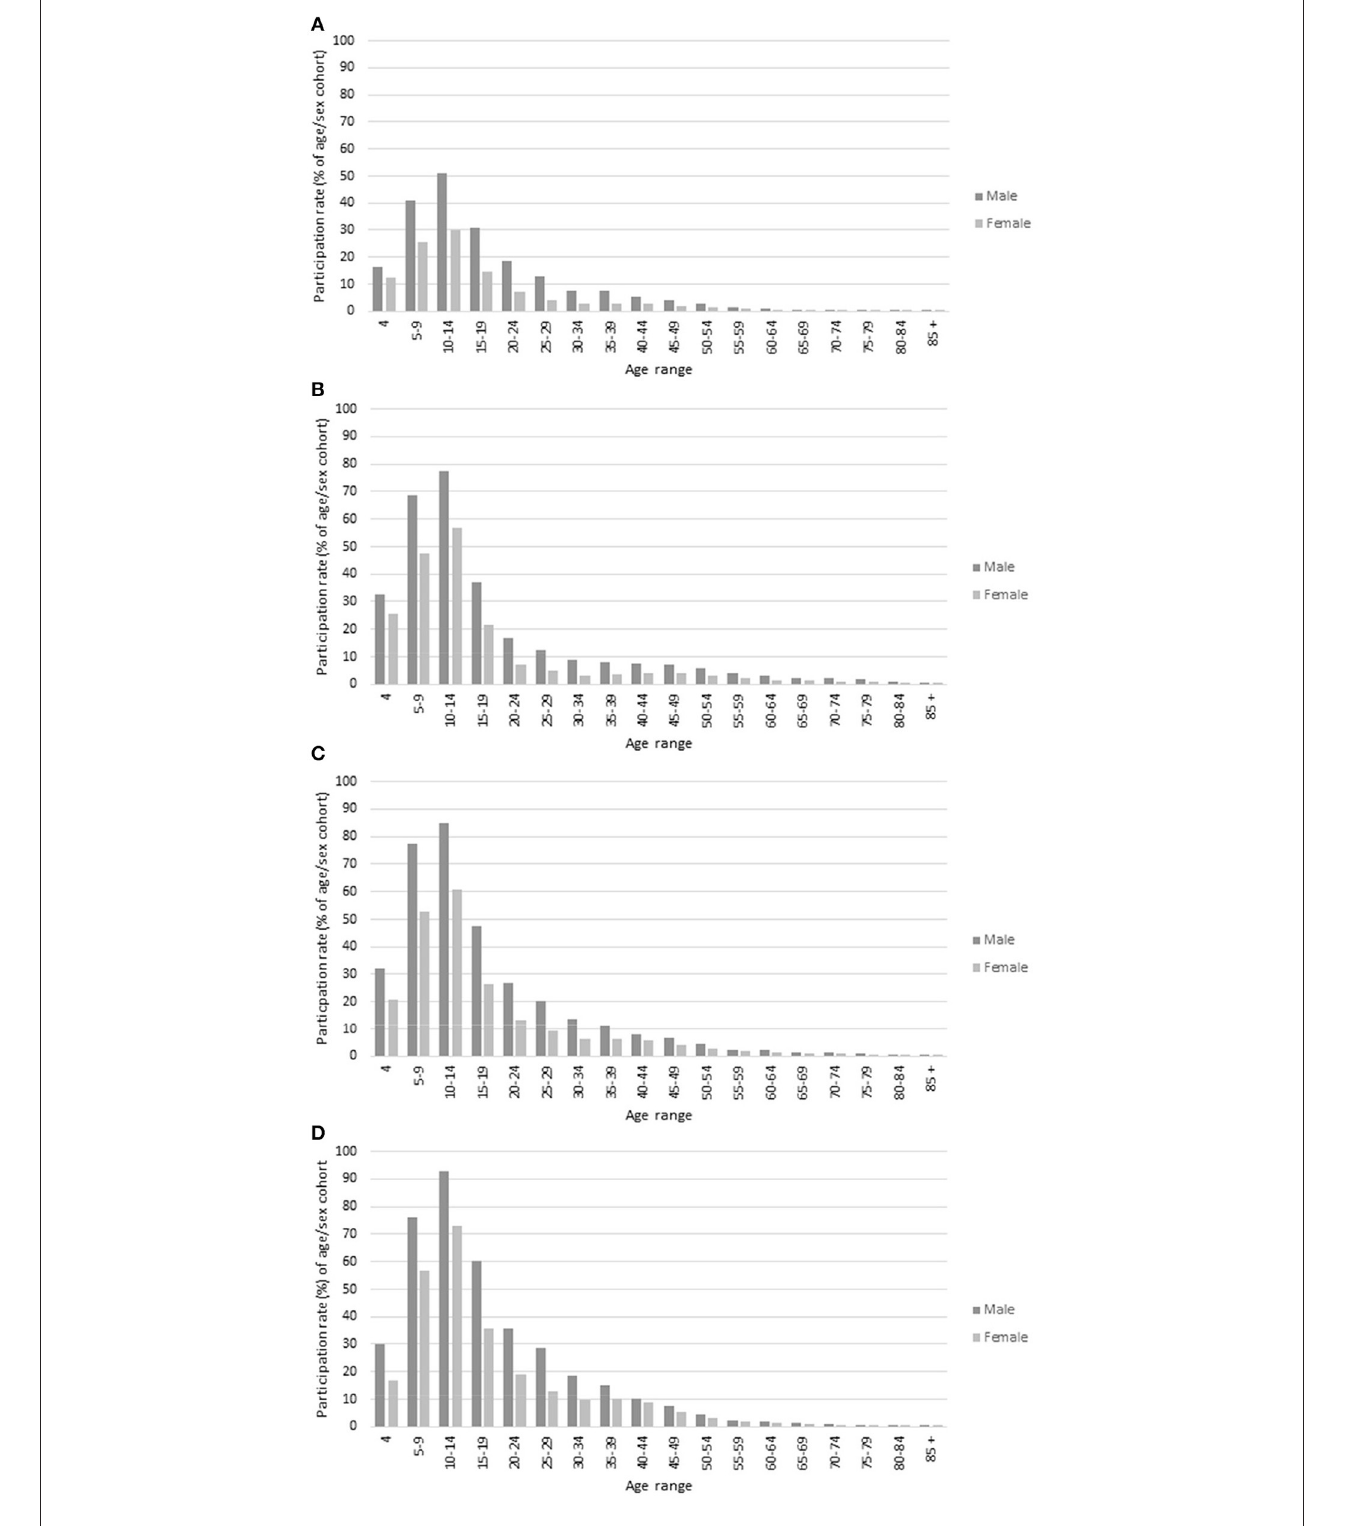
FIGURE 3 | Participation rates, 2019: by region, sex, and age. (A) Metropolitan—Growth, (B) Metropolitan—Other, (C) Regional—Growth, and (D) Regional—Other.